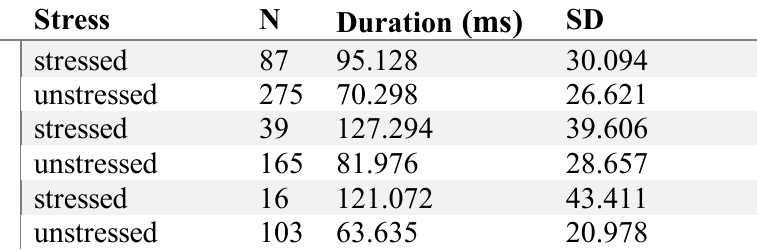
Table 3. Duration data (milliseconds) in closed syllables, subcategorised by following con-